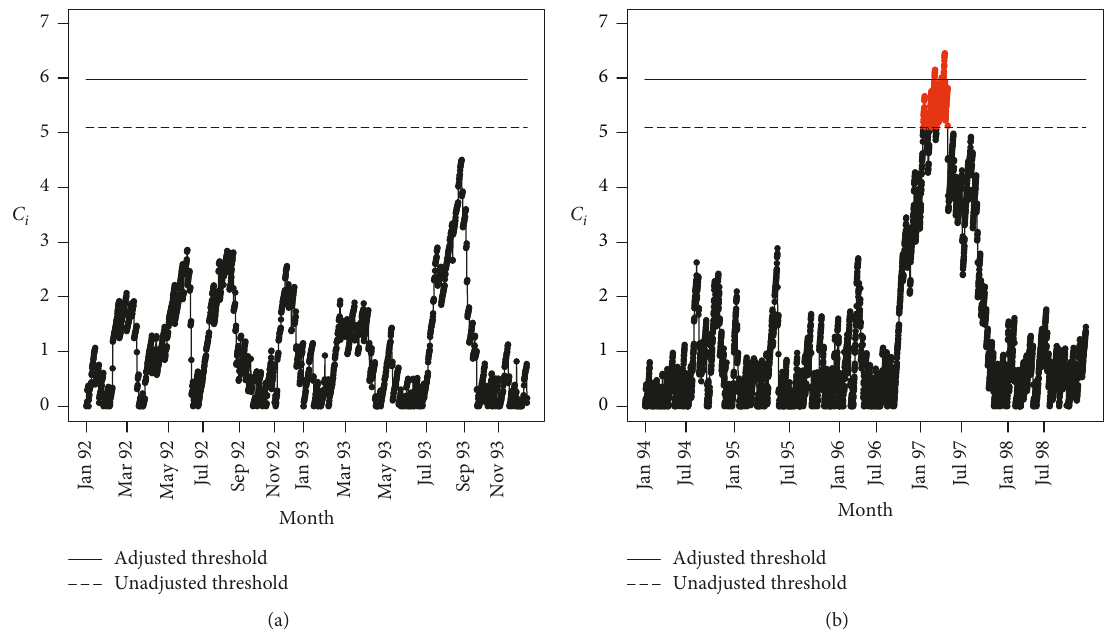
Figure 3: RA-CUSUM chart for Phase-I and Phase-II assuming first two years as the Phase-I for 30 days mortality of cardiac surgery patients. (a) Phase-I chart, unadjusted UCL � 5.093 and adjusted UCL � 5.97. (b) Phase-II chart, unadjusted UCL � 5.093 and adjusted UCL � 5.97.